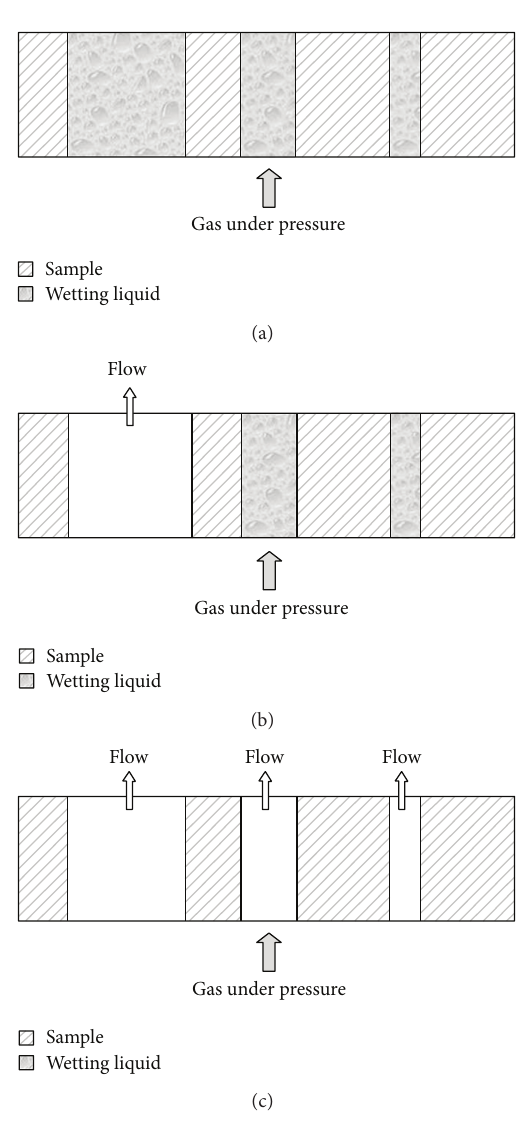
Figure 1: Principle of capillary flow porometry. As a result of gas pressure exerted on the sample (a), the largest existing pore is emptied first through which the flow is now measured (b). Then, in a descending order, smaller pores will be emptied until all the pores are empty